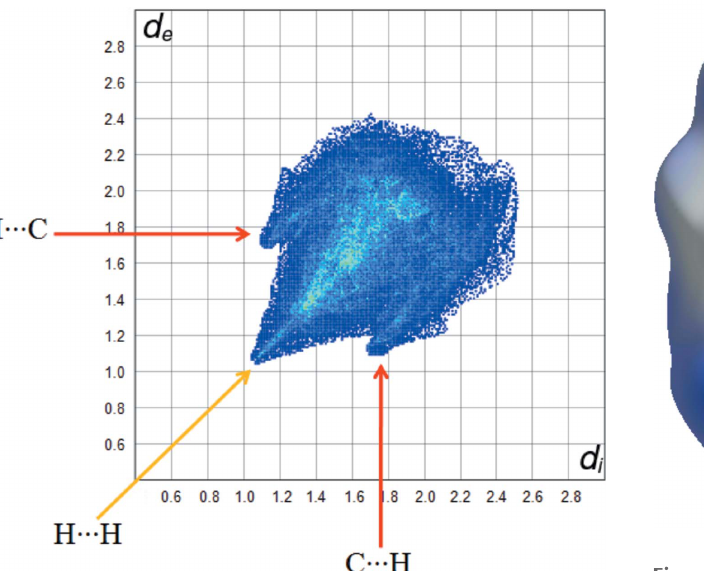
Figure 4 A fingerprint plot for the title compound.